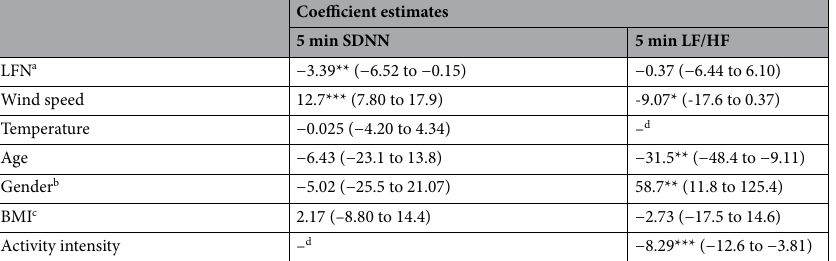
Table 2. Estimated percentage changes (95% CI) in (a) the 5 min SDNN and (b) the 5 min LF/HF per interquartile range (IQR) (7.86